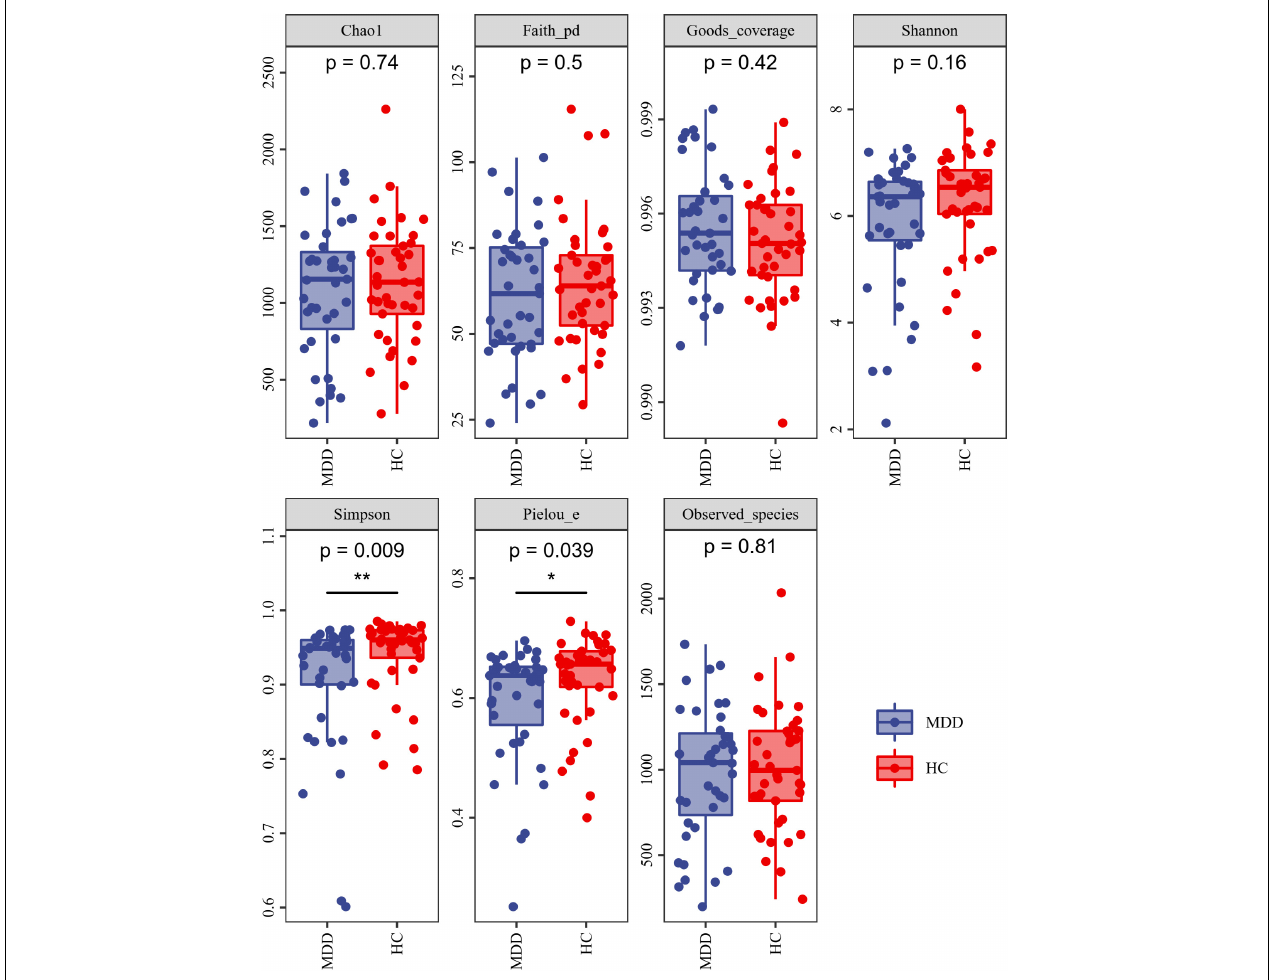
FIGURE 2 | Alpha diversity of MDD and HCs samples. The blue and red colors represent MDD group and HC group, respectively. * P < 0.05 and ** P <